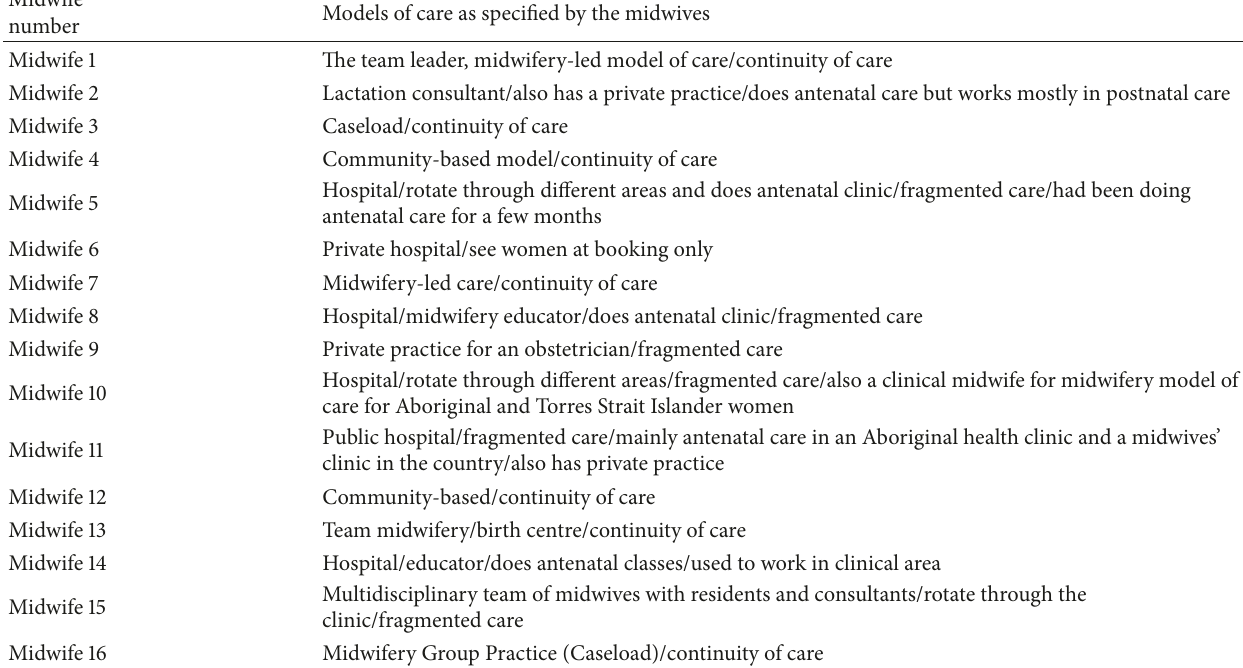
Table 1: Midwives’ specified models of